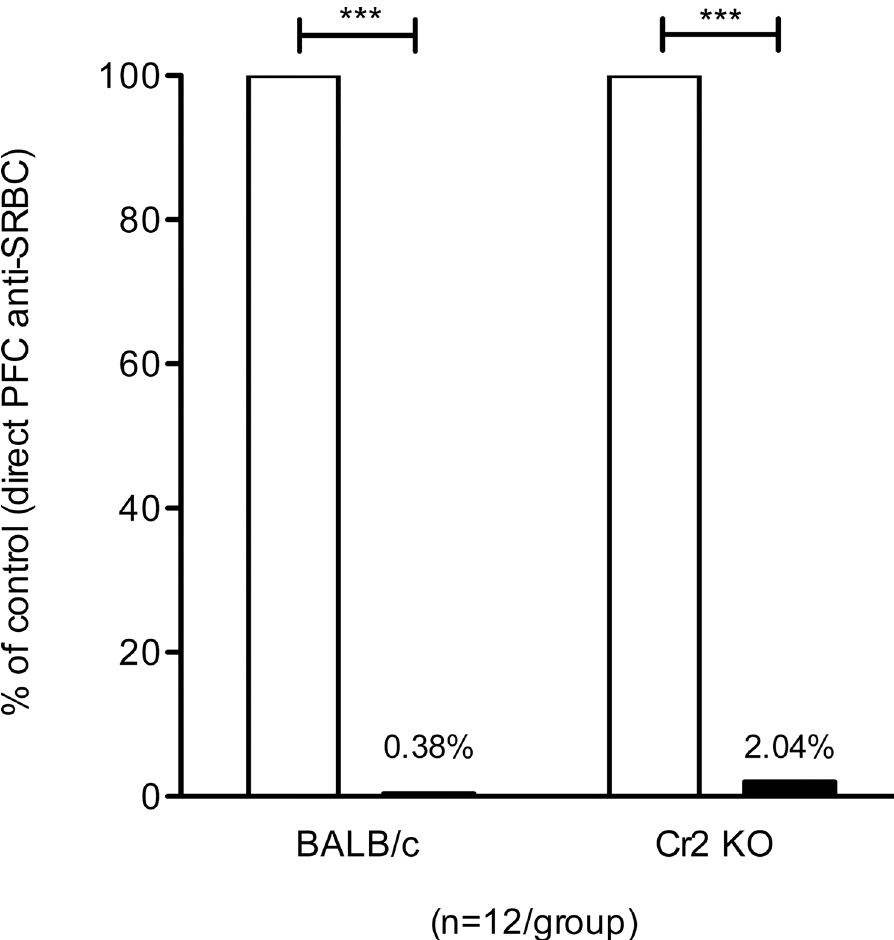
Fig 2. IgG-mediated suppression of primary IgM-responses in Cr2 KO mice. Cr2 KO and BALB/c mice were immunized with 50 μ g IgG b anti-SRBC and 5x10 7 SRBC, SRBC alone, or IgG alone. Five days after immunization, the number of spleen cells producing IgM anti-SRBC was assayed. Responses are shown as percentage of the direct PFC response/spleen in mice given SRBC alone (100%, open bars); black bars show responses in mice given IgG together with SRBC. Direct PFC/spleen in the respective control groups (receiving antigen alone) were: BALB/c, 76,208; Cr2 KO, 11,015. Data are pooled from three experiments; (n = 4/group in each experiment). p-values denote comparisons between mice immunized with IgG anti- SRBC together with SRBC and mice immunized with SRBC alone. *** , p <